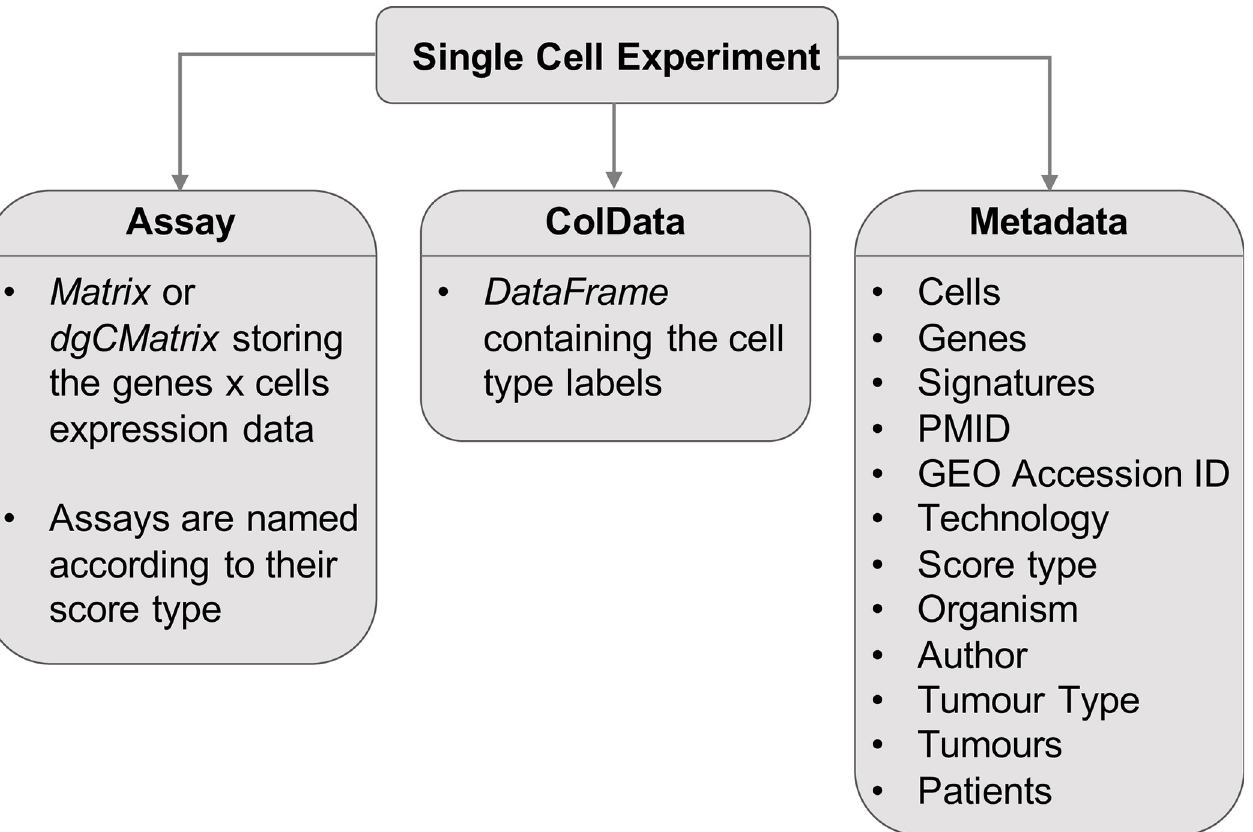
Fig 2. The format of the SingleCellExperiment objects containing TME datasets. The Assay is a matrix or dgCMatrix containing the gene expression table, named according to the type of score (i.e. an Assay containing raw counts would be named “Counts”); colData is a DataFrame with the number of rows equal to the number of columns in the Assay and describes the cells in the dataset; Metadata is a named list of additional metadata objects describing the dataset. A SingleCellExperiment object may contain one or more AltExps , which are nested SingleCellExperiment objects containing a different score type in the Assay.